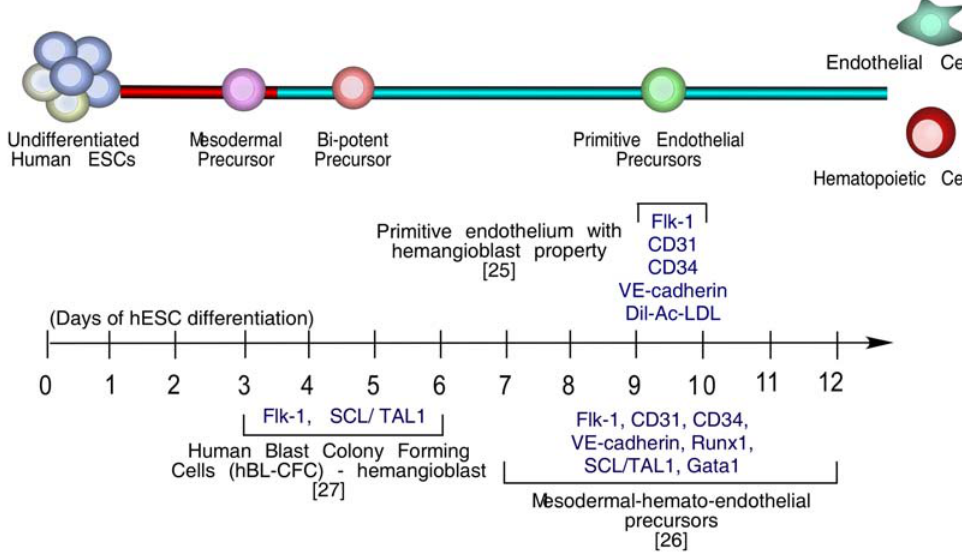
FIGURE 2. The schematic development of hESCs into hematopoietic and endothelial lineages. Two independent research groups have shown that hematopoietic and endothelial cells arise from an intermediate primitive endothelial- like or mesodermal hematoendothelial precursor with hemangioblast properties. Using an experimental approach similar to those employed in mESCs, the third research group recently demonstrated that a Flk-1 + progenitor, derived from 3- to 4-day-old differentiated hEBs, is capable of giving rise to a transient human blast colony-forming cell (hBL-CFC). These hBL-CFCs have hemangioblast properties and are capable of further development into hematopoietic and endothelial lineages. Since various research groups employ different experimental approaches, it remains unclear whether the same or distinct populations of bipotent precursors were